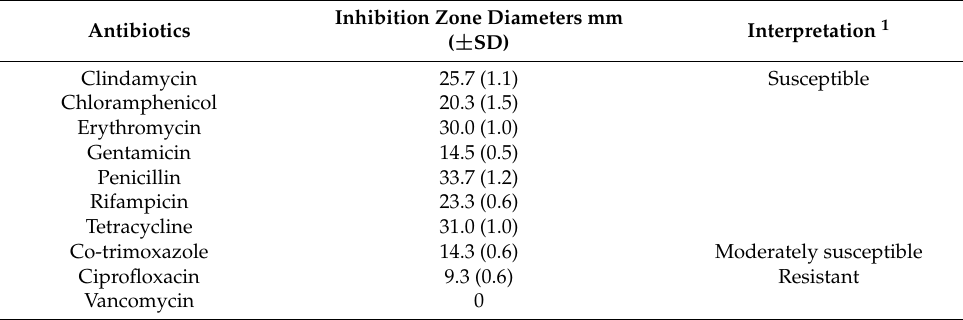
Table 6. Antimicrobial susceptibility of L. plantarum ATCC 8014 by the agar overlay diffusion